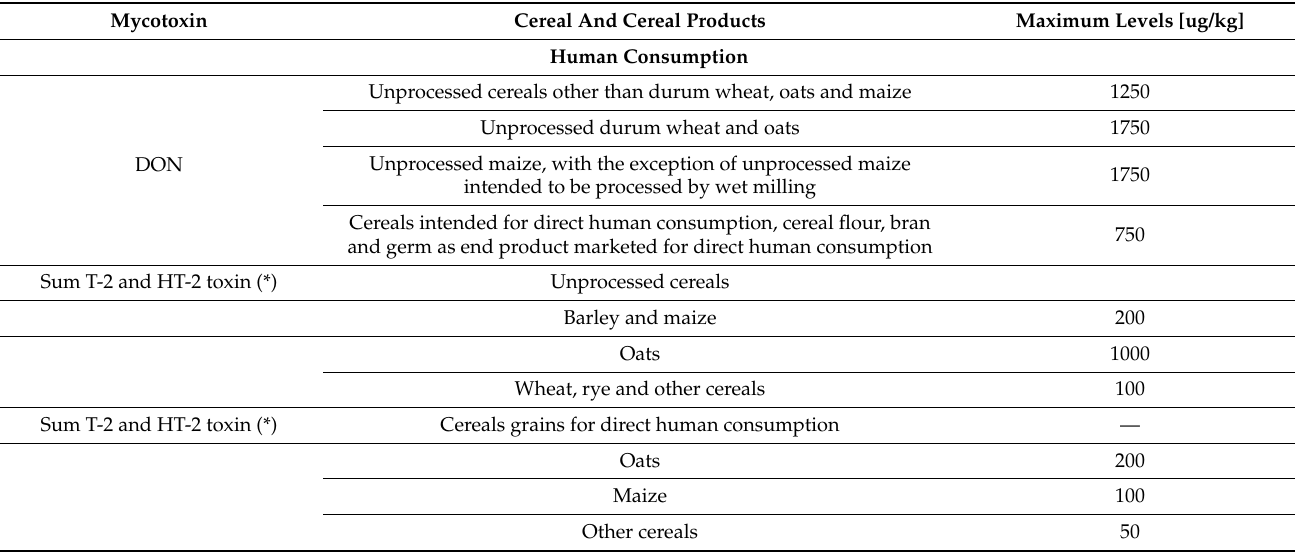
Table 5. Maximum levels for mycotoxins in cereals and cereal products for human consumption [165,166] and in products intended for animal feed